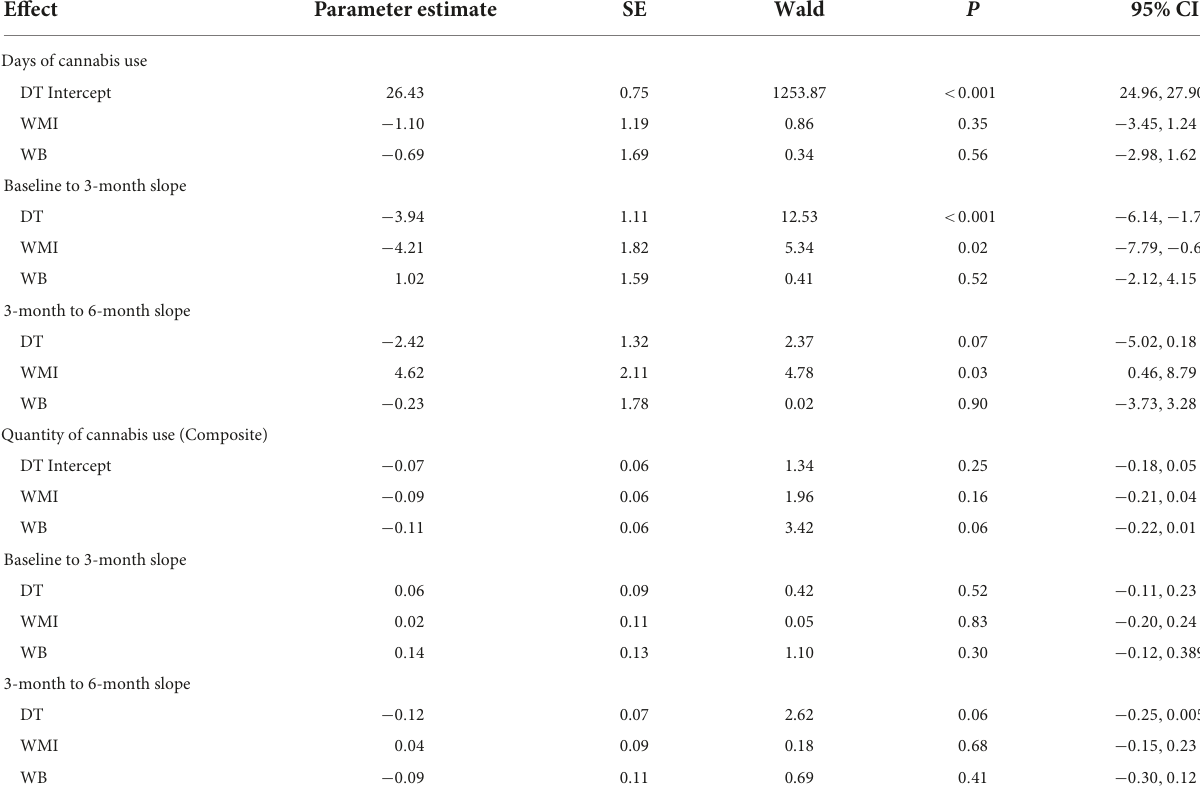
TABLE 6 Parameter estimates for days and quantity of cannabis use from GEE modeling.